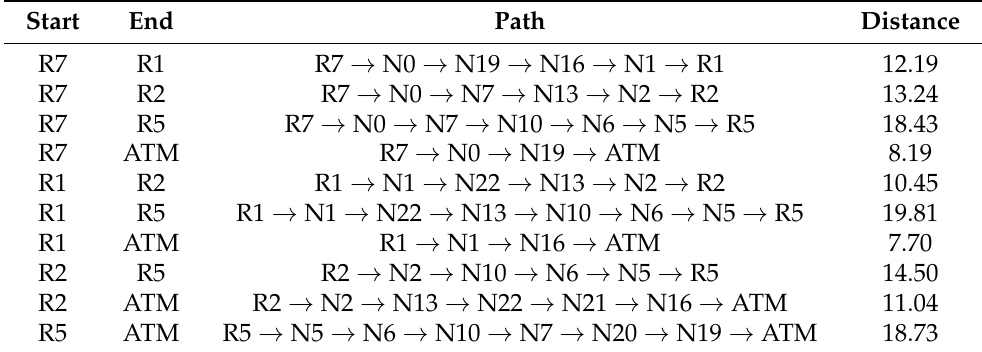
( b ) The navigation path of ITSP Figure 2. ( a ) The navigation network of the indoor scene. ( b ) Illustration of the undirected graph of all selected desired destinations. Table 2. Navigation path between any two selected places.